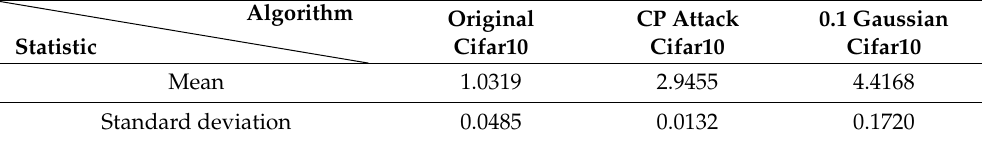
Table 9. Mean and standard deviation values of reconstruction error for attacks on Cifar10 dataset.